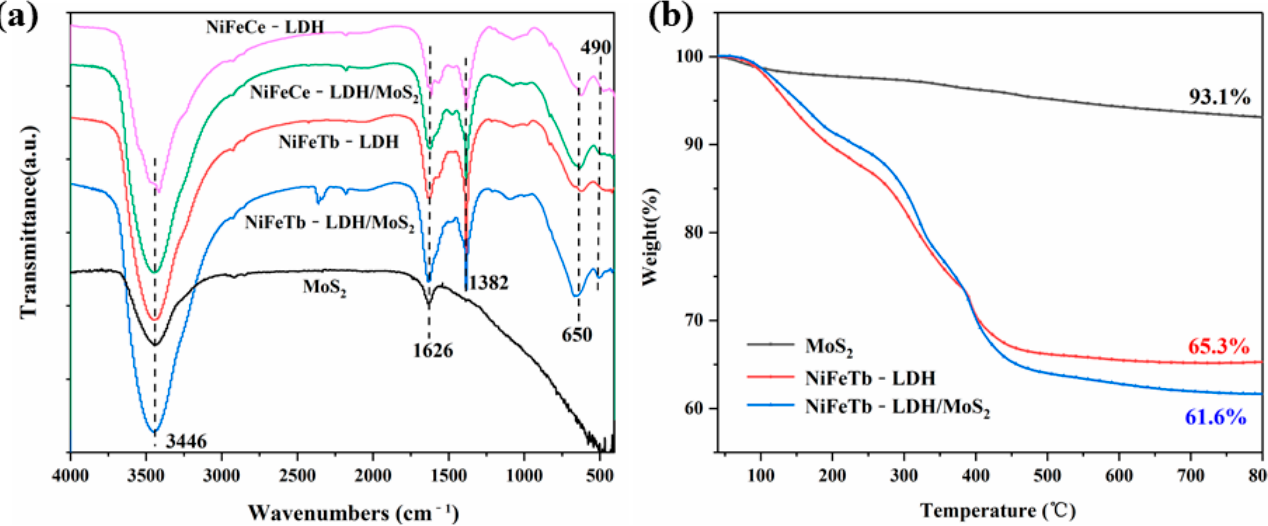
Figure 3. FTIR spectra of MoS 2 , NiFeCe-LDH, NiFeCe-LDH/MoS 2 , NiFeTb-LDH and NiFeTb- LDH/MoS 2 ( a ); TG curves of MoS 2 , NiFeTb-LDH and NiFeTb-LDH/MoS 2 ( b ).